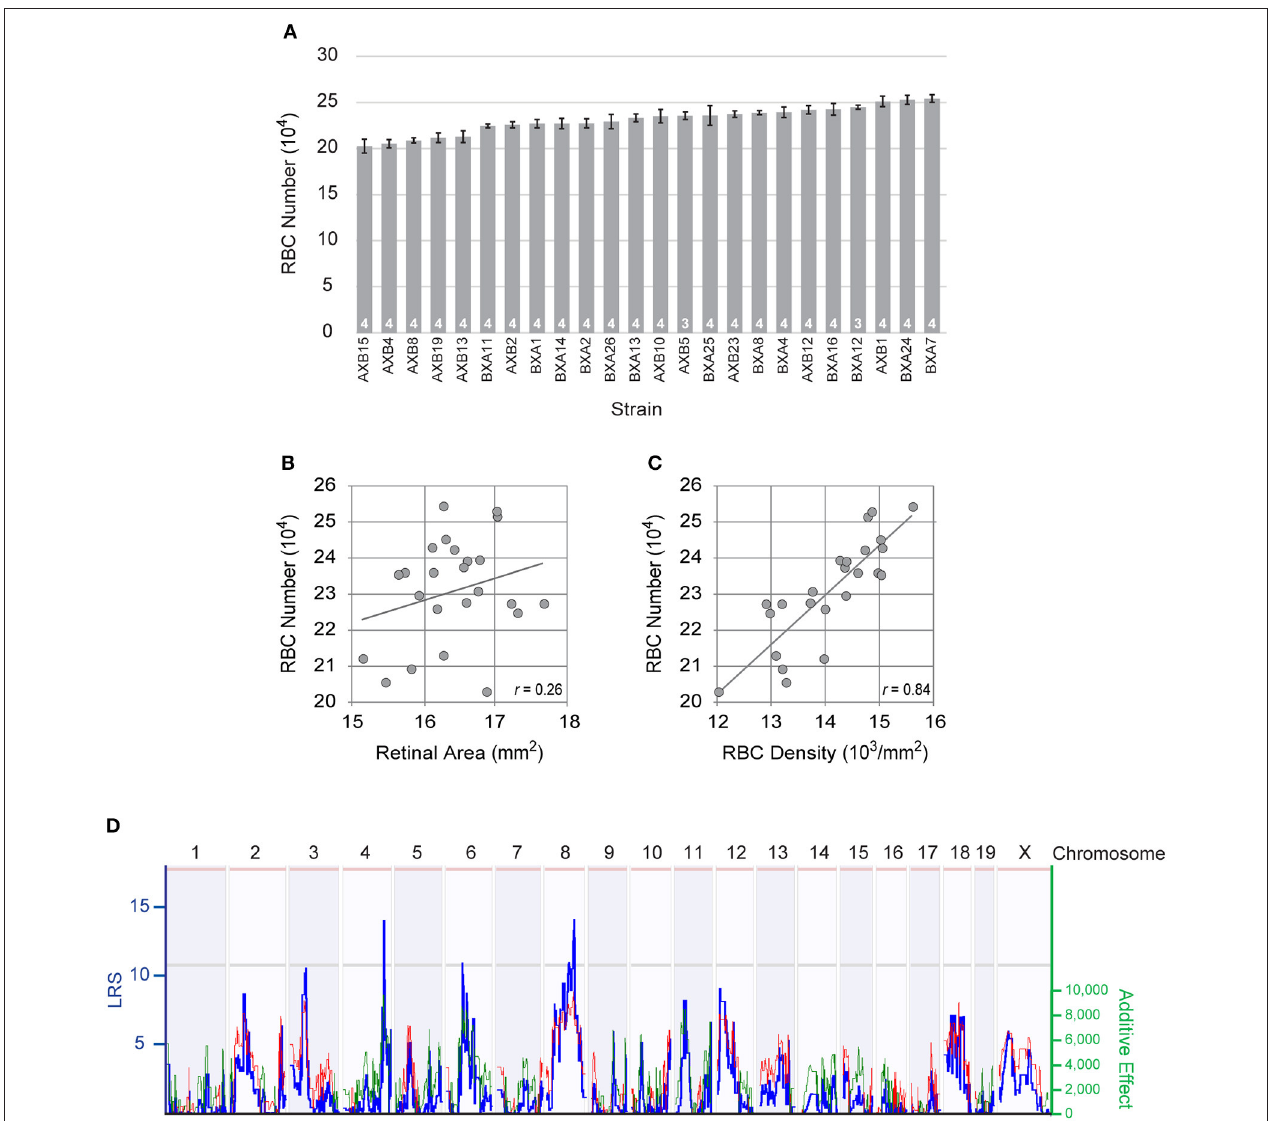
FIGURE 2 | (A) The total number of RBCs showed large variation across the RI strains of the AXB/BXA strain set, while evidencing only modest within-strain variation. n = the number of retinas sampled per strain. (B) Retinal area varied slightly across the RI strains, but did not correlate significantly with RBC number. (C) Rather, the density of RBCs correlated significantly with RBC density. The Pearson correlation coefficient ( r ) is indicated. (D) Variation in RBC number mapped three large-effect quantitative trait loci (QTL) on Chrs 4, 6, and 8, where A alleles at the former loci and B alleles at the latter locus correlated with an increase in RBC number. The blue trace plots the likelihood ratio statistic (LRS), indicated on the left Y-axis. Suggestive and significant thresholds for the LRS defined by 1,000 permutation tests of the strain data are indicated by the gray and pink horizontal lines, respectively. The right Y-axis plots the additive effect of the contribution of a single allele upon trait values. The effect of two alleles at each of these three loci modulated the trait by 19,294 cells, 17,535 cells, and 18,413 cells, respectively. Note as well other lesser loci present across the genome, including those on Chrs 3 and